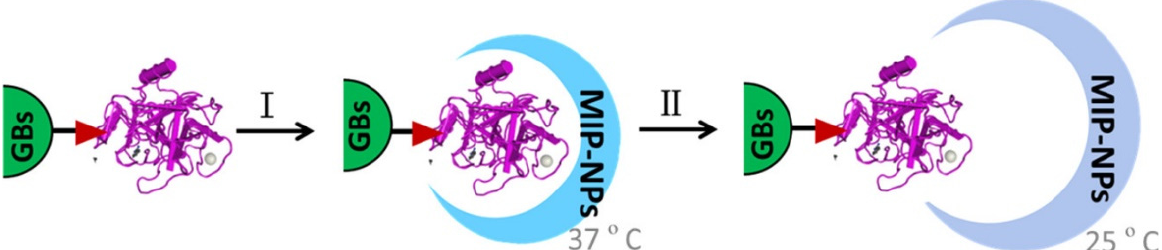
Figure 3. Schematic depiction of the solid ‐ phase synthesis of MIP ‐ NPs. I: polymerization; II: release of thermoresponsive MIP ‐ NPs (temperature change from 37 °C to room temperature, 25 °C). Reprinted with permission from [76]. Copyright 2016 American Chemical Society.